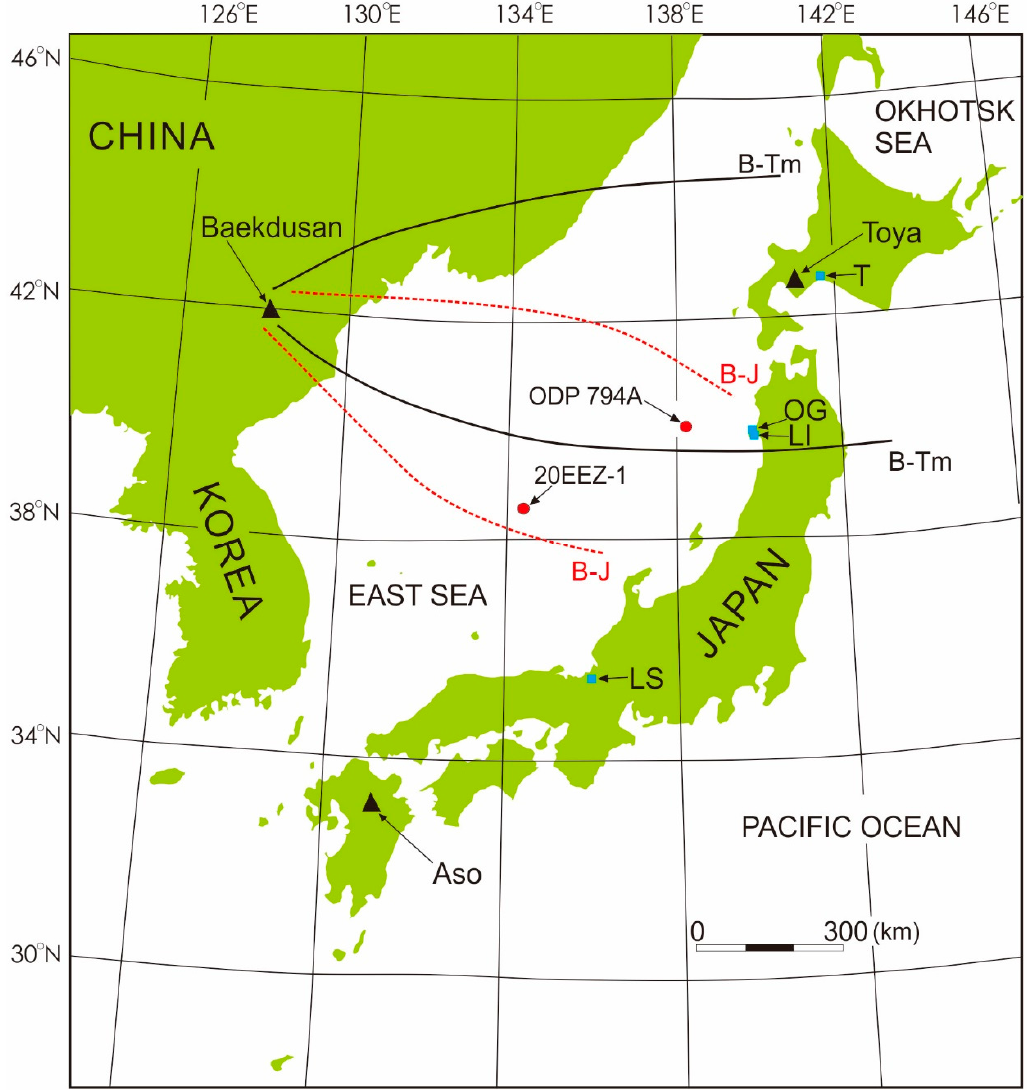
Figure 1. Map of coring sites and source volcanoes in the East Sea / Japan Sea. Solid black line: trajectory of the B-Tm tephra (Adapted from [1]), Dotted red line: trajectory of the B-J tephra (Adapted from [18]), Solid black triangles: Source volcanoes in this study, Solid red circles: Coring sites in this study. Blue squares: Sampling sites in Japanese island. T: Tomakomai, OG: Oga Peninsular, LI: Lake Ichi-no-Megata, LS: Lake Suigetsu.